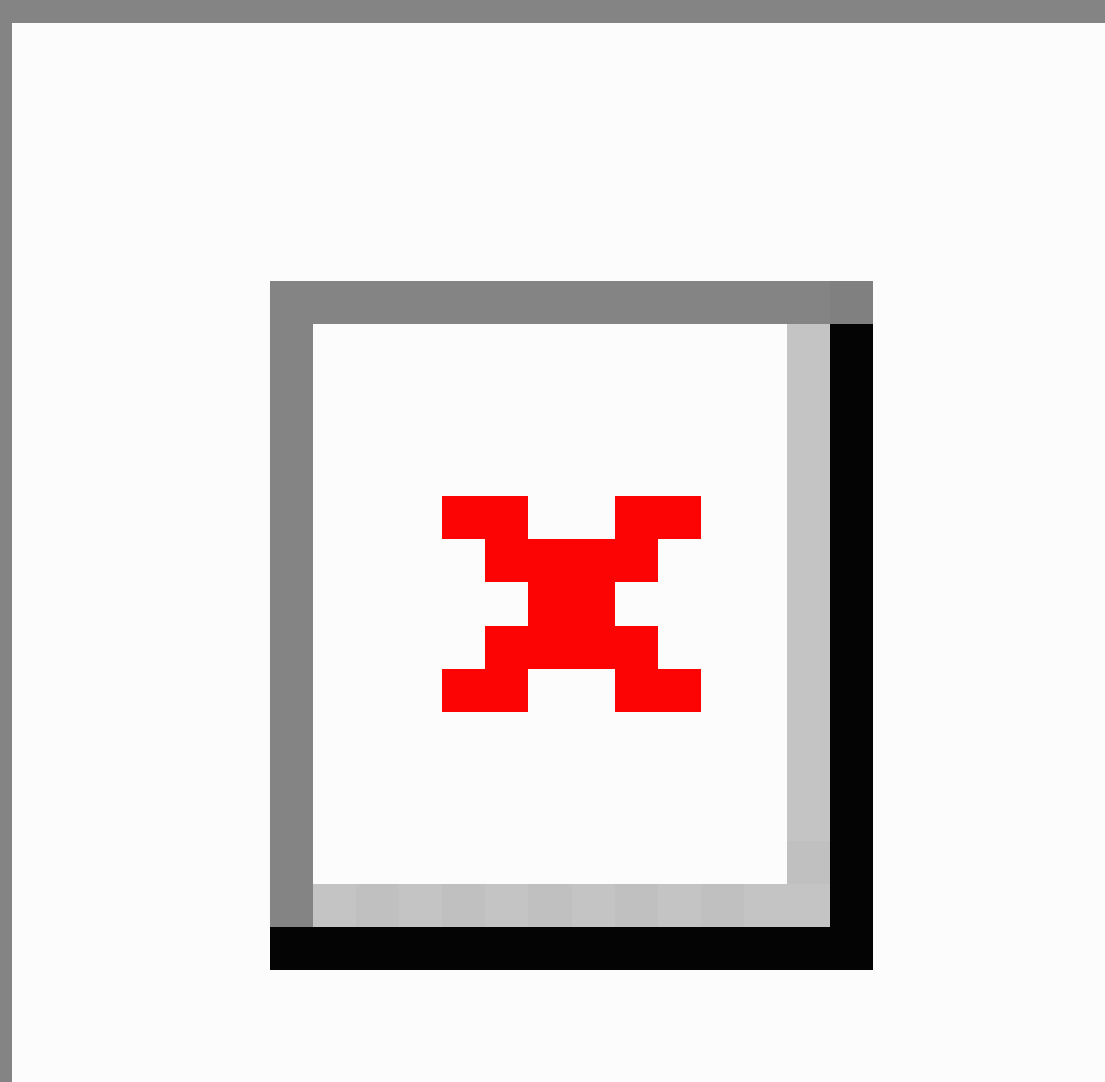
Figure 5. Performance of the convolutional neural network and dermatologists of different expertise levels in the identification of rosacea and other skin diseases. A. Precision and accuracy of the convolutional neural network compared to those of resident doctors, attending physicians, and experts; B. Sensitivity and specificity of the convolutional neural network compared to those of resident doctors, attending physicians, and